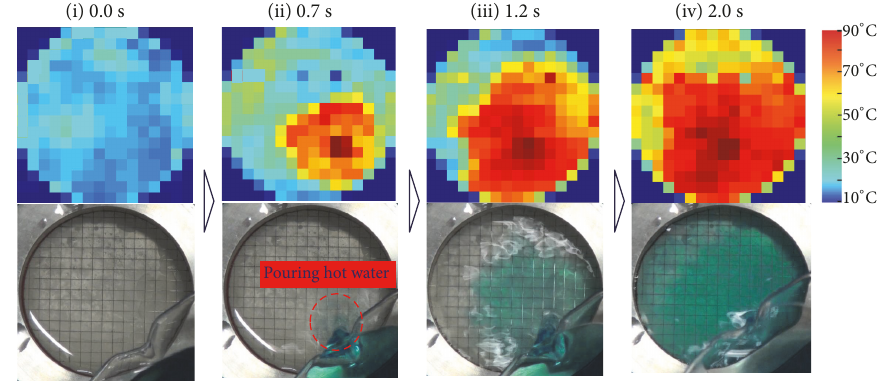
Figure 7: Mixing process of a hot-water jet into a cold-water pool.